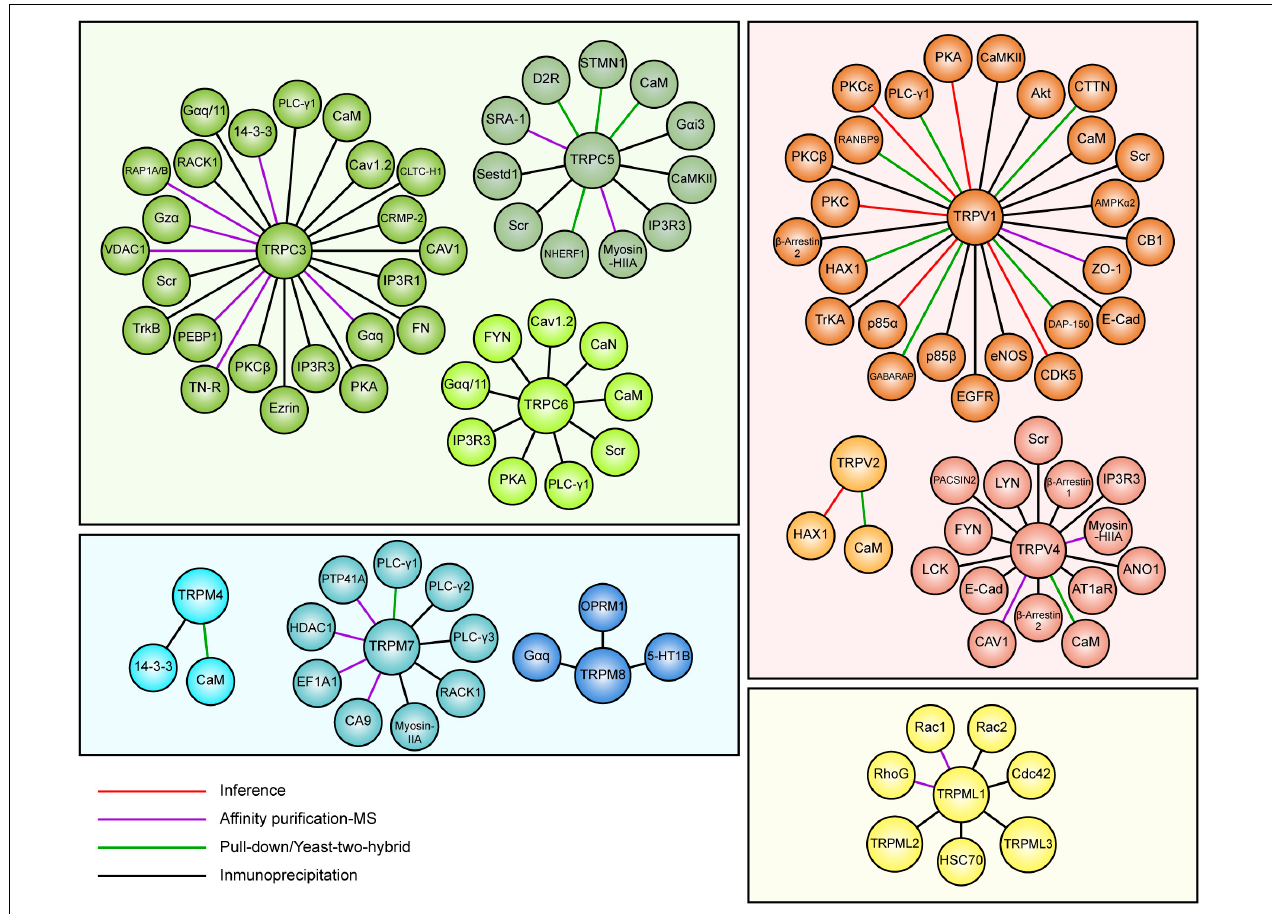
FIGURE 2 | Map of curated TRP ion channel interactors associated with Rho GTPases pathways. Data obtained from the TRIP database showing interactors of TRPC3, TRPC5, TRPC6, TRPV1, TRPV2, TRPV4, TRPM4, TRPM7, TRPM8, and TRPML1. TRP channels members are grouped and color-coded by